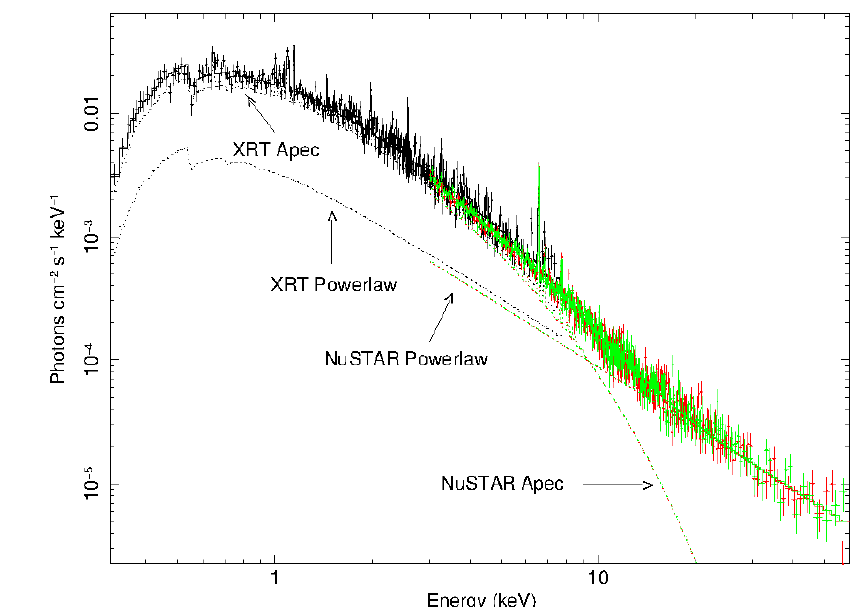
Figure 3. XRT and NuSTAR unfolded data and model for the 3 November 2015 observations. Apec and powerlaw contributions for XRT and NuSTAR are marked. XRT data and model are shown in black, NuSTAR FPMA in red and NuSTAR FPMB in green color. Shift between model components for XRT and NuSTAR is due to relative normalization introduced to account for cross-calibration between XRT and NuSTAR. Apec contributes significantly at energies below 20 keV. Powerlaw dominates at higher energies.